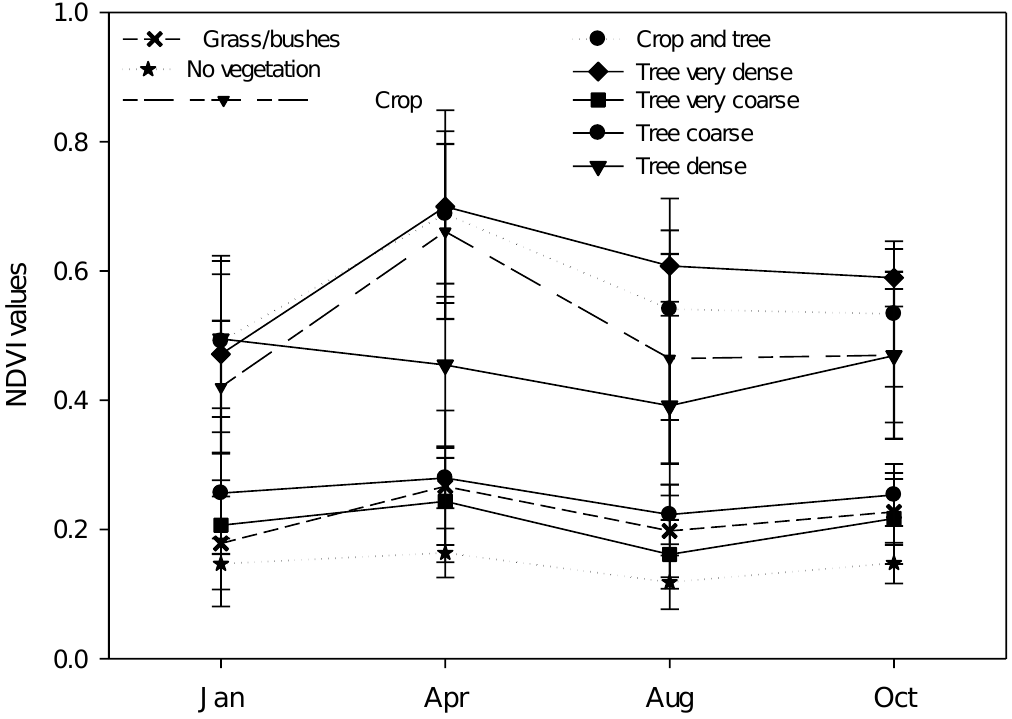
Figure 7. Dynamics of NDVI in four periods in the High Atlas Mountains of Morocco, as calculated from Landsat 8 (2020).